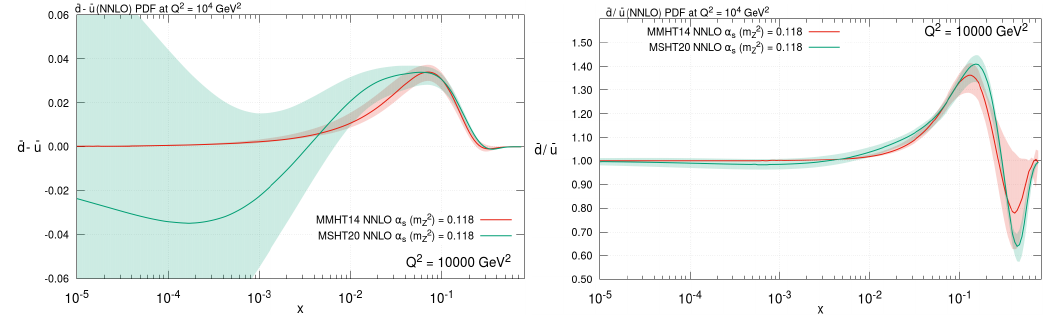
Figure 6: The MSHT20 ¯ u , ¯ d difference compared to MMHT14.